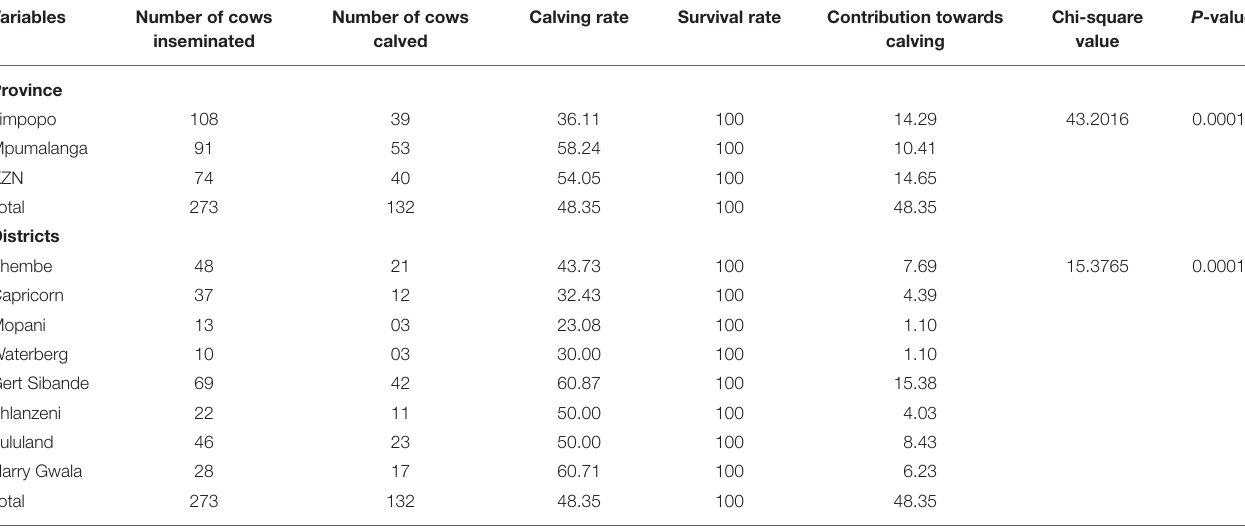
TABLE 5 | Effect of province and districts on calving and survival rate of cows under communal and emerging farming systems. Variables